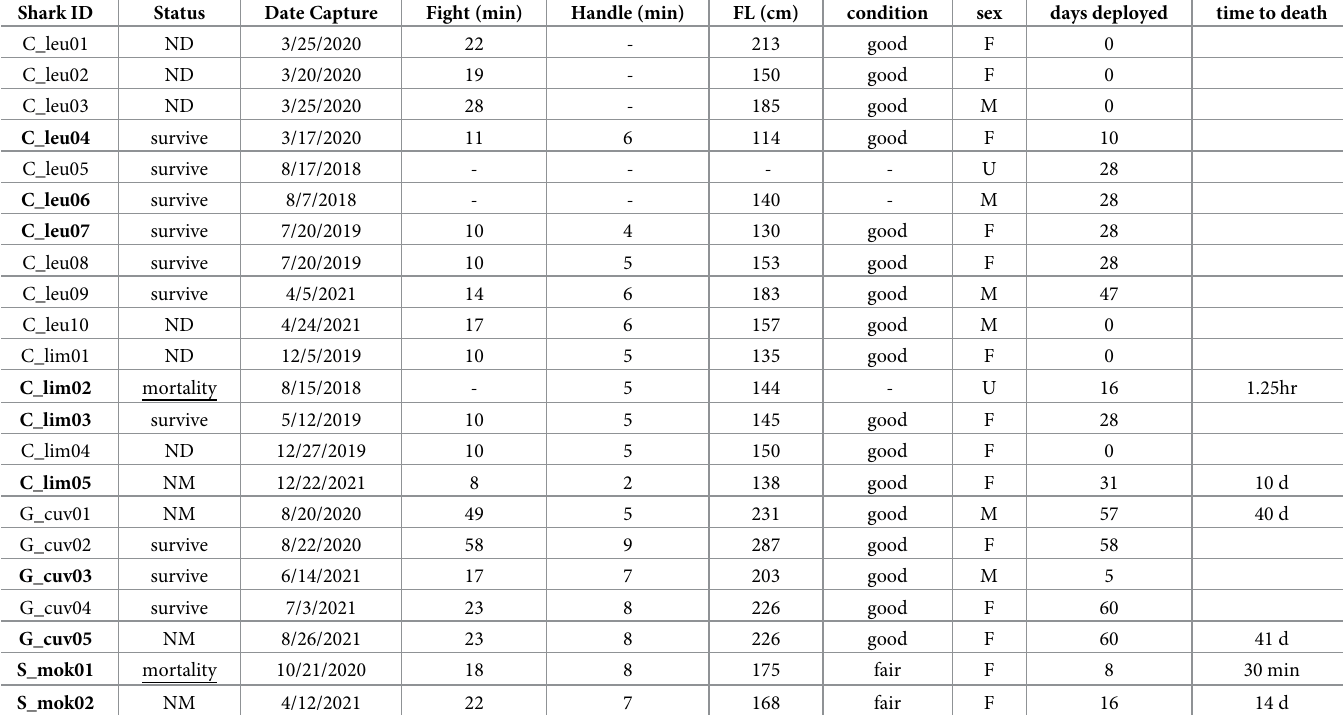
Table 2. Results of 22 PSAT tags deployed on bull sharks, blacktip sharks, tiger sharks, and great hammerheads in the Gulf of Mexico by shore-based recreational anglers. The tags from Shark IDs in bold were recovered, providing high-resolution datasets. FL = fork length; ND = no data. Underlined individuals indicate instances of PRM, and individuals denoted with natural mortality (NM) indicate instances of mortality occurring � 10 days post